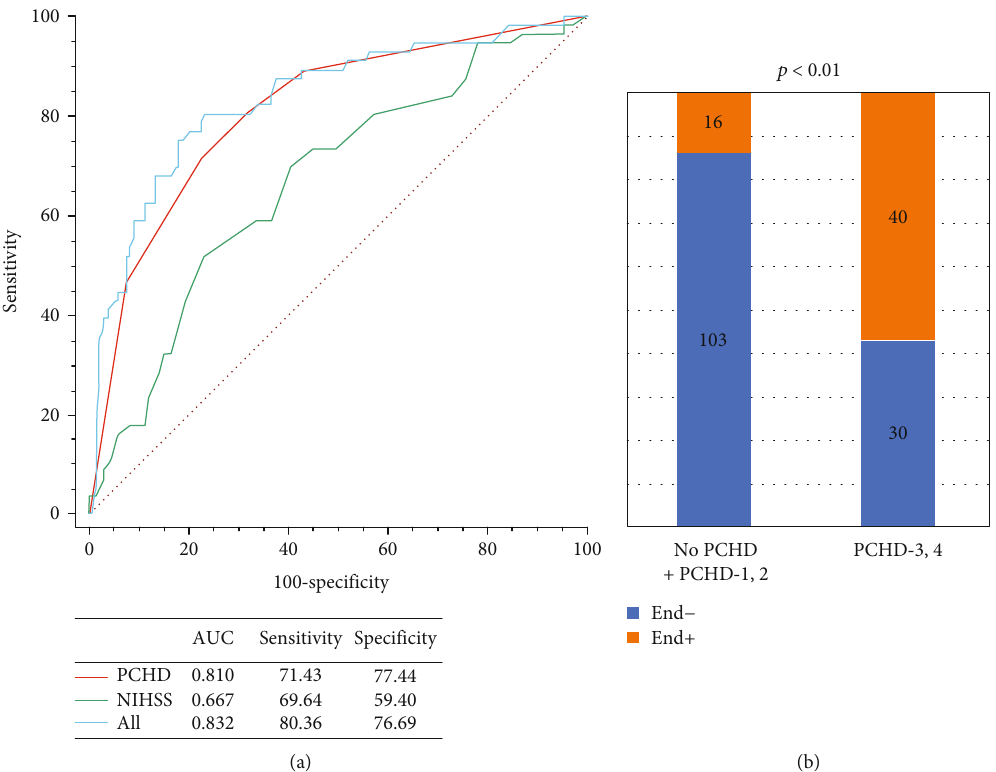
Figure 5: Evaluation of the accuracy of END. (a) ROC curves for the NIHSS score at admission and PCHD in predicting END. (b) The probability of END in the high-risk group was signi fi cantly higher than that in the low-risk group, and the optimal diagnostic cuto ff value was PCHD > 2 .